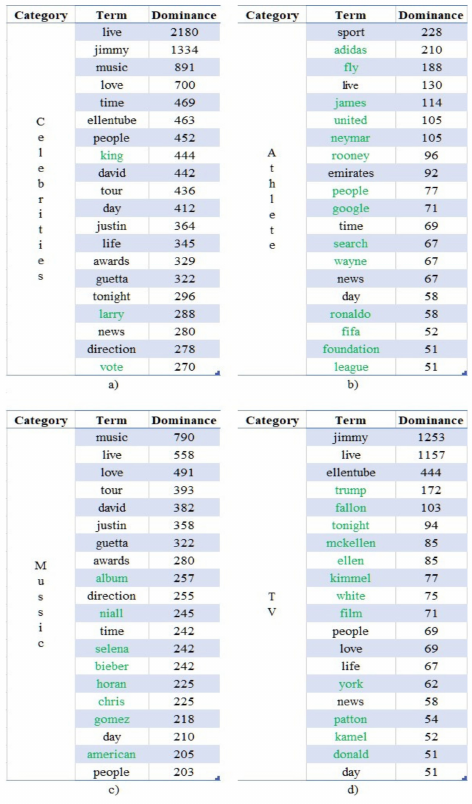
Figure 8. The top 20 dominant OCR terms ( a – d ) per community of